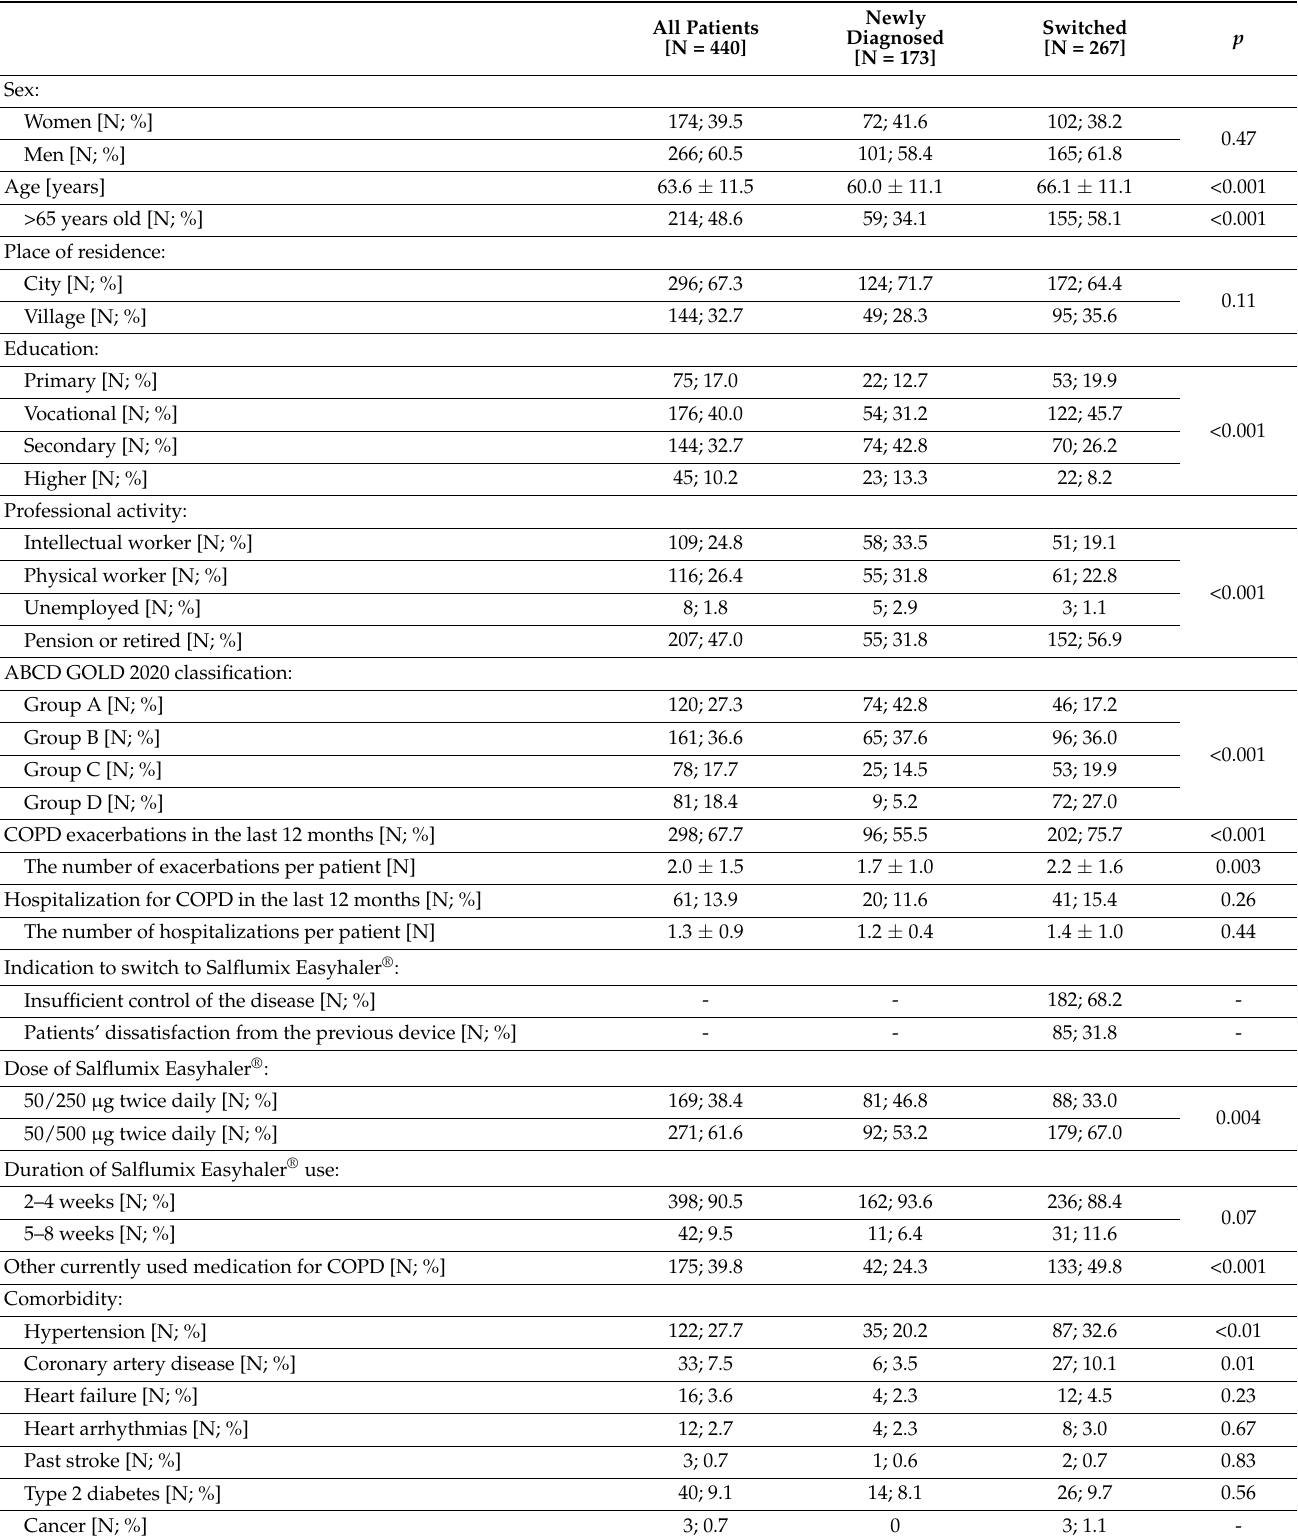
Table 1. Characteristics of 440 COPD, newly diagnosed, and switched that recently commenced therapy with Salflumix Easyhaler ®